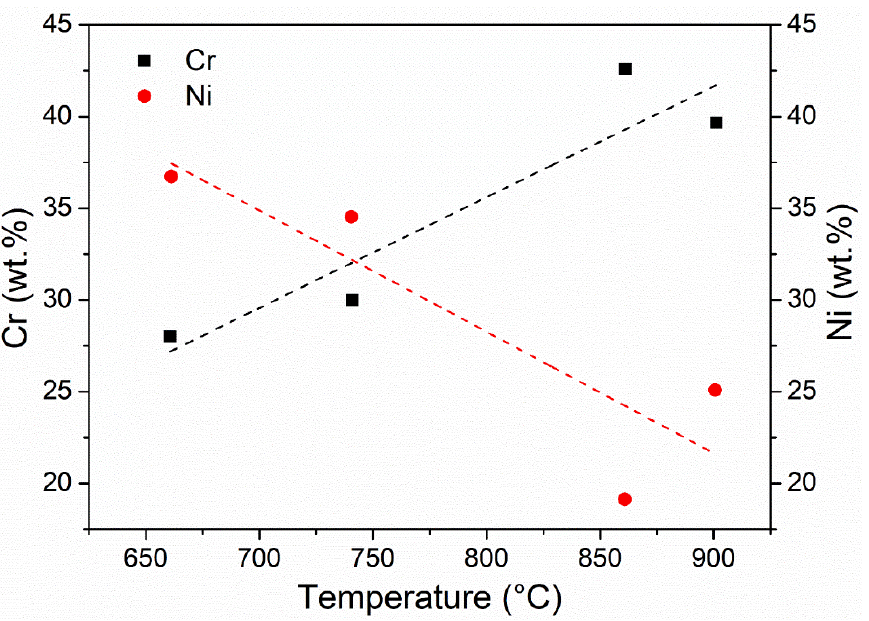
Figure 12. Cr and Ni contents in the oxide layers formed on Ni-based alloy as a function of the temperature.